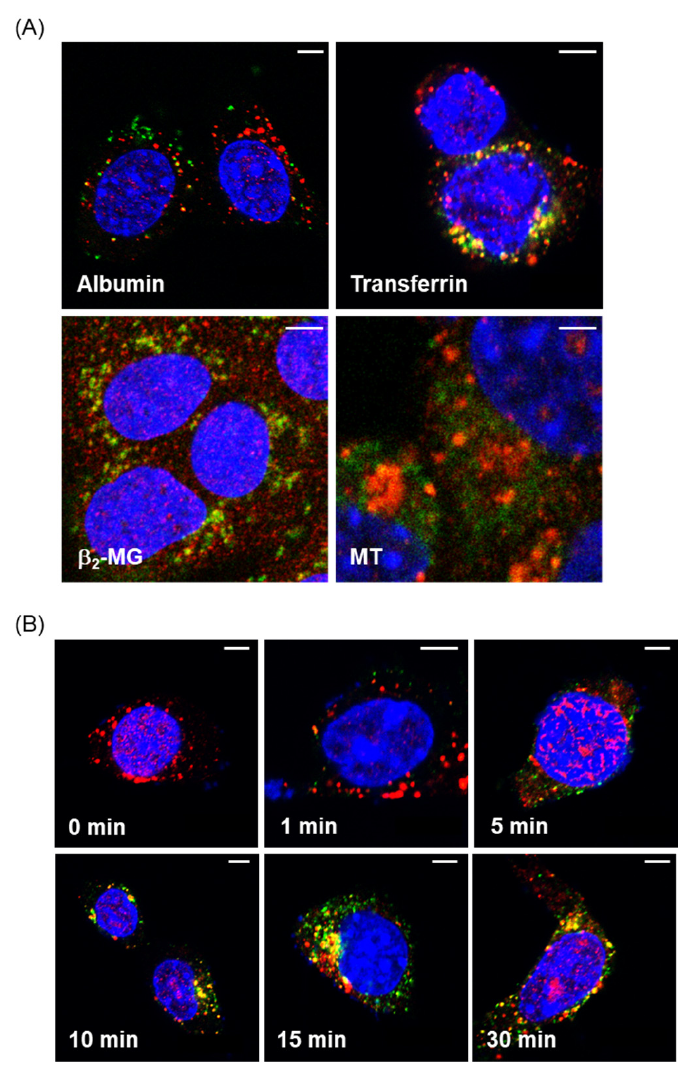
Figure 1. Fluorescence imaging of endocytosed proteins in mouse proximal tubule epithelial cell (PTEC)-derived S1 cells. ( A ) S1 cells were incubated with 50 µg/mL fluorescein isothiocyanate (FITC)-albumin, Alexa-transferrin, FITC- β 2 -MG, or FITC-MT (green) for 30 min and then fixed with paraformaldehyde for immunofluorescence labeling with anti-EEA1 (red). Yellow staining demonstrates the colocalization of fluorescent-labeled proteins and early endosomes. ( B ) S1 cells were incubated with Alexa-transferrin for 1, 5, 10, 15, and 30 min. The localization of Alexa-transferrin (green) and early endosomes stained with anti-EEA1 (red) was visualized by confocal microscopy. Bars, 5 µ